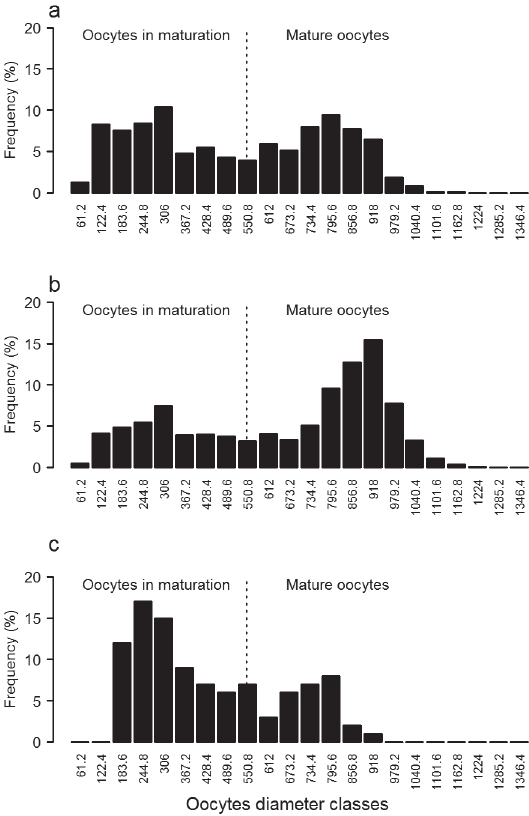
Figure 4 - Frequency distribution (%) of oocytes diameters (µm) in Astyanax intermedius . a – oocytes in early stages of maturation (N = 42 females); b – oocytes in last stages of maturation (N = 169 females) and c – oocyte distribution classes for a female after spawning (N = 1).